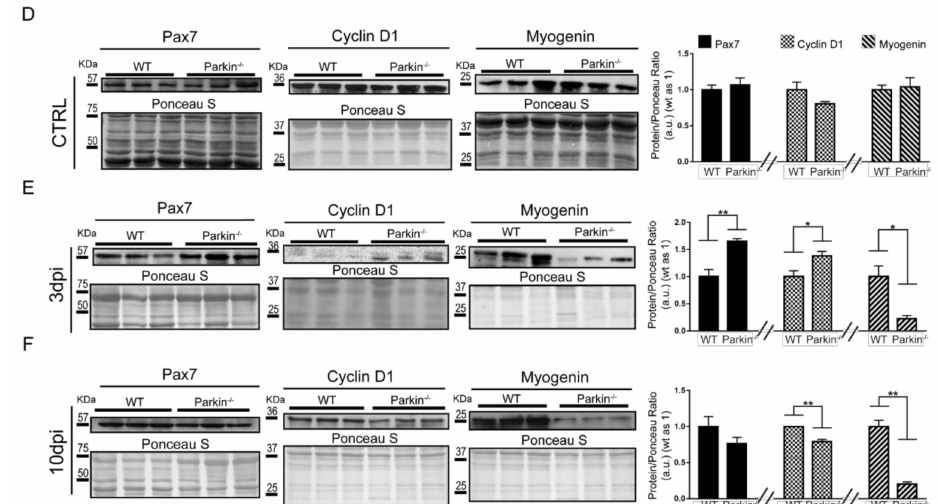
Figure 5. Absence of Parkin results in commitment of MuSCs to cell cycle and reduced Myogenin expression. ( A ) Immunofluorescence of Pax7 (red), Myogenin (green), and DAPI (blue) in TA muscle cryosections from WT and Parkin − / − mice at 3 and 10 dpi. White arrowheads indicate Pax7 + cells and white arrows indicate Myogenin + cells. The split channels are presented in Figure S2. The images were acquired with a 40 × and 20 × objectives respectively. Bars represent 20 µ m. ( B ) % of Pax7 + and Myogenin + cell in TA muscle from WT and Parkin − / − mice at 3 and 10dpi. Data represent means ± SD ( t -test: * p < 0.05; *** p < 0.01; n = 5). ( C ) Immunofluorescence of Myh3 (red) and DAPI (blue) of TA muscle cryosections from WT and Parkin − / − mice at 10dpi. The graphs represent Myh3 positive cells by area and total area occupied by Myh3 cells. The myofibers are marked by dotted areas. Data represent means ± SD ( t -test: * p < 0.05; ** p < 0.01; n = 5). The images were acquired with a 20 × objective. Bars represent 50 µ m. ( D ) Western blot and densitometry analysis of Pax7, Cyclin D1, and Myogenin levels in TA muscle from WT and Parkin − / − mice in CTRL. Ponceau S staining was used to normalize for loading. Data represent means ± SEM ( n = 6). ( E ) Western blot and densitometry analysis of Pax7, Cyclin D1, and Myogenin levels in TA muscle from WT and Parkin − / − mice at 3dpi. Ponceau S staining was used to normalize for loading. Data represent means ± SEM ( t -test: * p < 0.05; ** p < 0.01; n = 6). ( F ) Western blot and densitometry analysis of Pax7, Cyclin D1, and Myogenin levels in TA muscle from WT and Parkin − / − mice at 10dpi. Ponceau S staining was used to normalize for loading. Data represent means ± SEM ( t -test: ** p < 0.01; n =